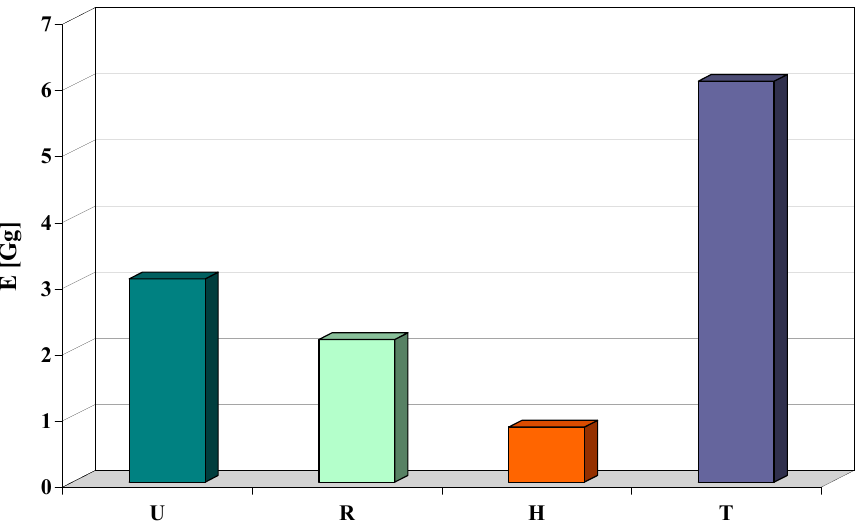
Figure 13. National annual emission (E) of black carbon (BC) under different traffic conditions: urban (U), rural (R), highway (H) and total (T).